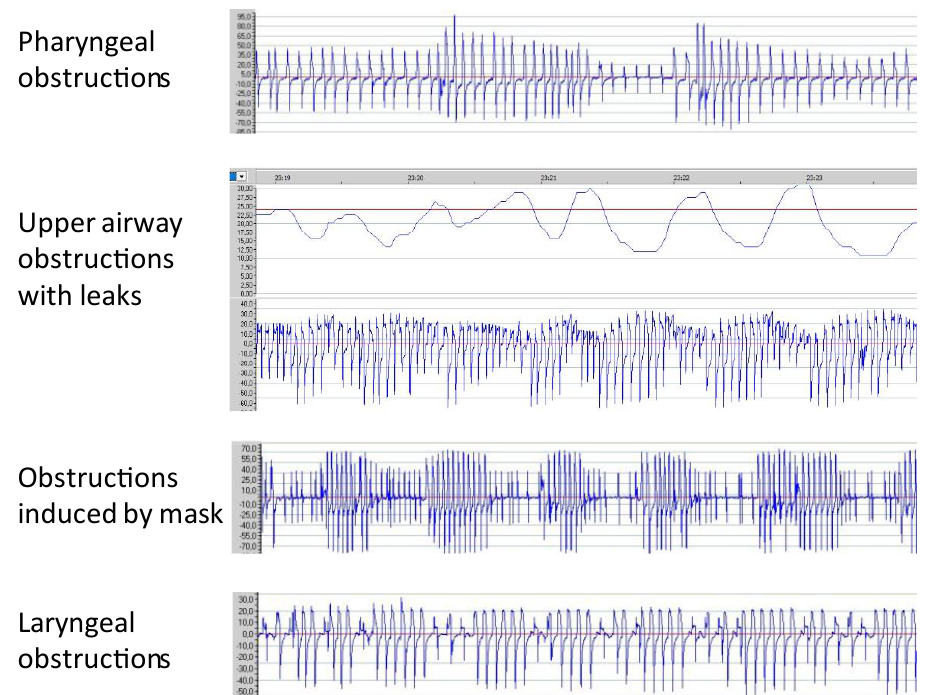
Figure 2. The flow waveform examination may show some respiratory events that are not always detected by the AHI. The shape of the decrease in flow suggests some mechanism and localization of the obstruction. However, a respiratory polygraphy is needed to characterize the mechanism.